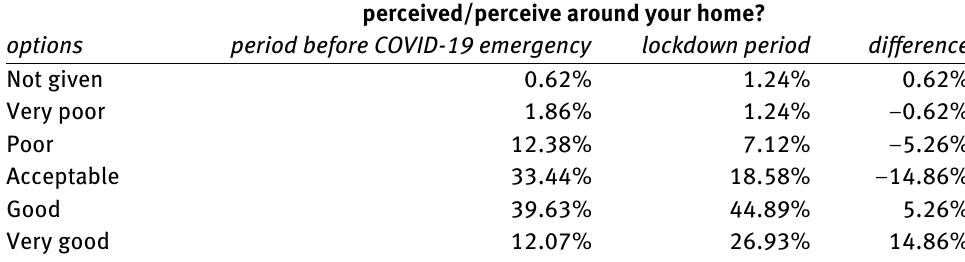
Table 15: Comparison between the lockdown period and the period before COVID-19 emergency regarding the assessment of the overall perceived environment How do you overall assess (sound, vision, safety, etc.) the environment